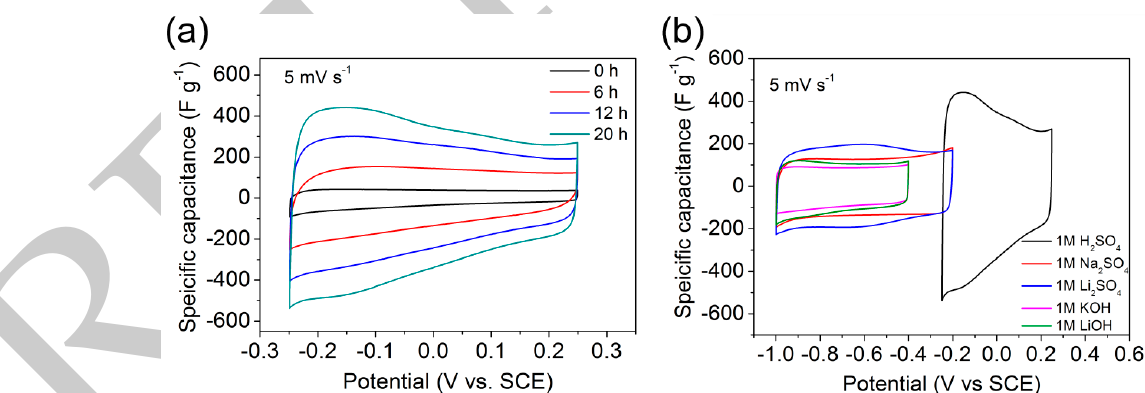
Figure 7. Electrochemical performance of Ti 3 C 2 T x and N-TiO 2 /TiN/Ti 3 C 2 T x electrodes in a three-electrode system. ( a ) CV profiles at 5 mV s − 1 for N-TiO 2 /TiN/Ti 3 C 2 T x electrodes in 1 M H 2 SO 4 . ( b ) CV profiles at 5 mV s − 1 for 20 h N-TiO 2 /TiN/Ti 3 C 2 T x in different electrolytes.